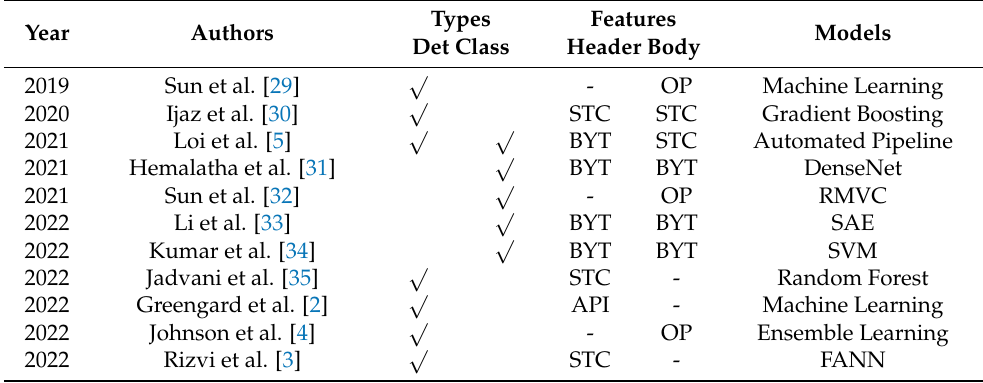
Table 1. Methods of static analysis for malware on